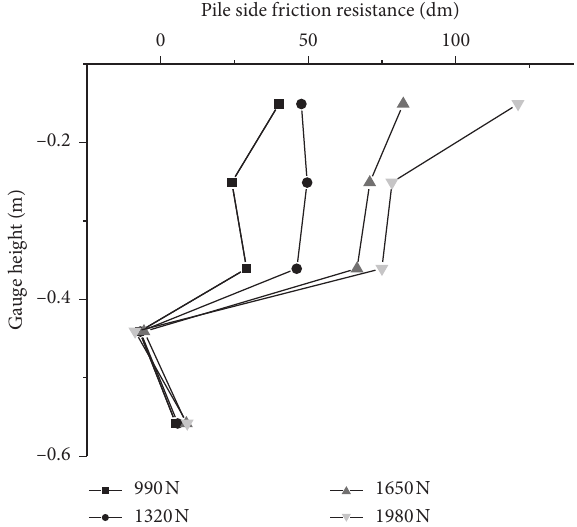
Figure 7: Change curve of pile side friction